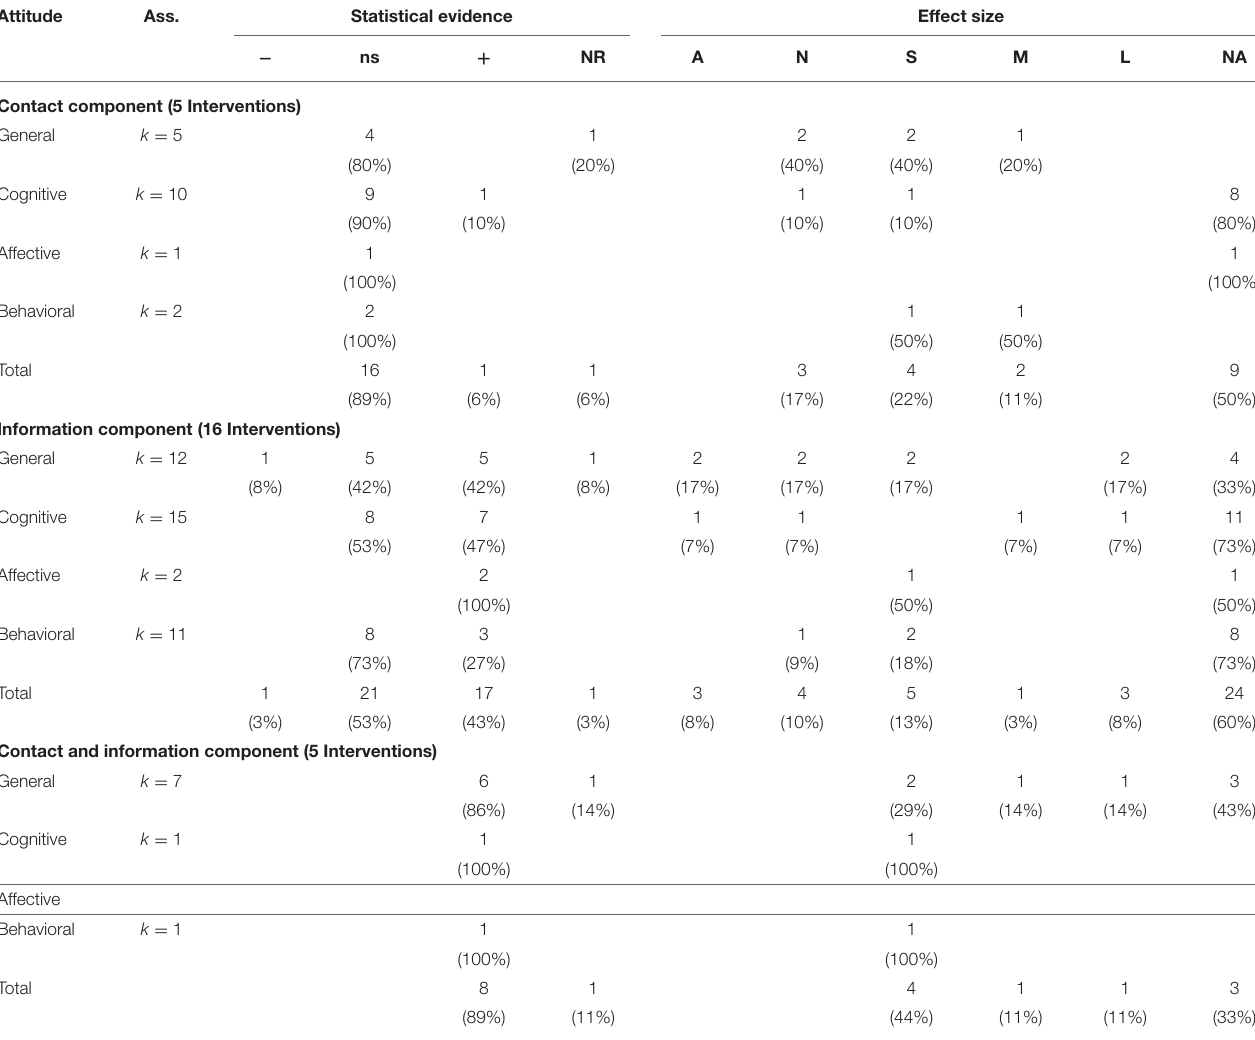
TABLE 4 | Associations by intervention component and by attitude component. Attitude Ass. Statistical evidence